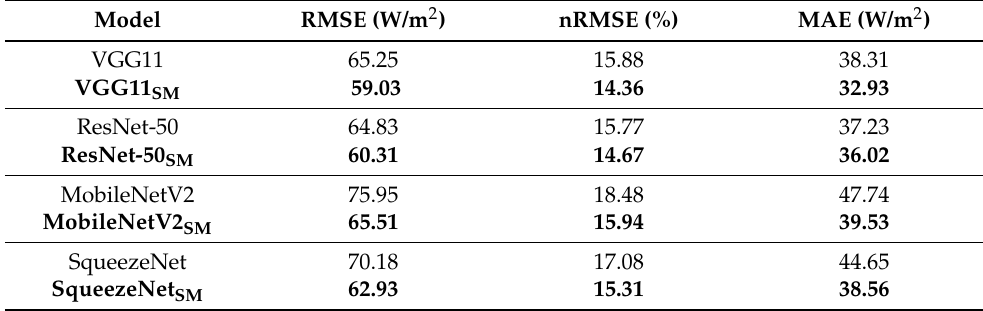
Table 2. Evaluation and comparison of the four models; SM indicates the models trained and evalu- ated with the four-channel images that include SunMask and the improved models are highlighted in